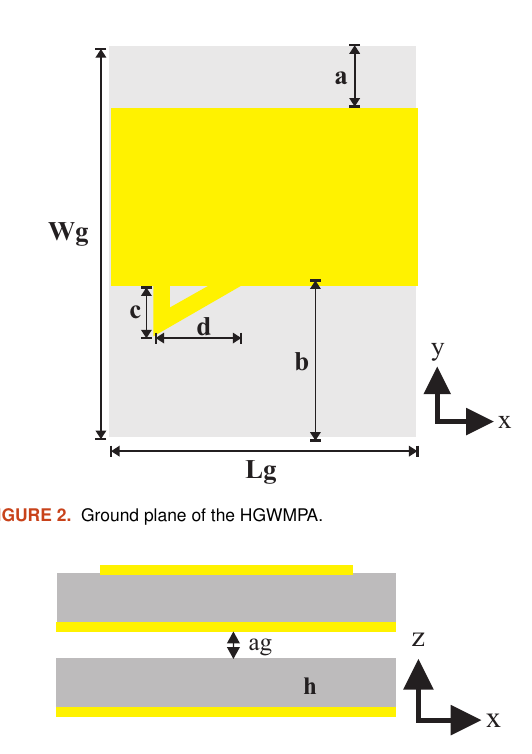
FIGURE 3. Side view of the HGWMPA.